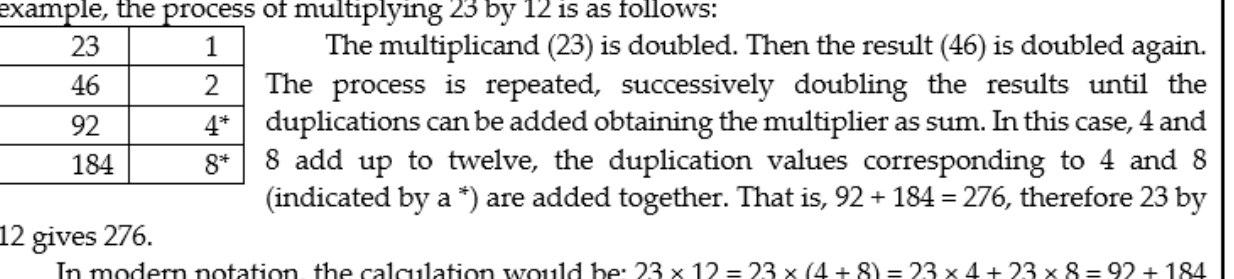
Figure 1. Description of the Egyptian multiplication method as presented to the students.